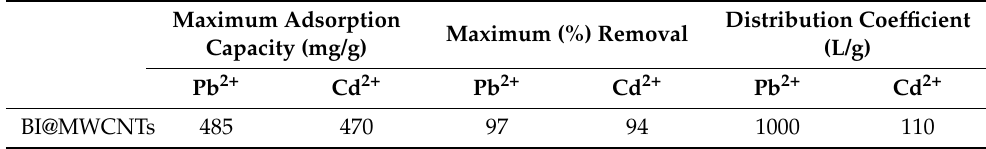
Table 2. Adsorption presentation of BI@MWCNTs applied for the removal of Pb 2+ and Cd 2+ at a pH 5 and 100 mg/L metal start